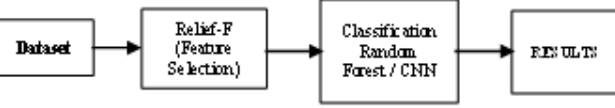
Figure 1. Customer churn prediction Approach using Relief-F with Random Forest and CNN